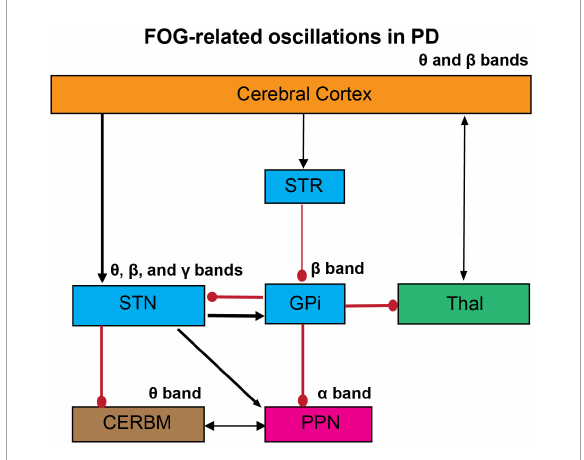
FIGURE1 The proposed oscillatory mechanism of FOG in PD. The abnormal gait in PD can be mediated by aberrant changes in the oscillatory activities across cortical and subcortical networks. FOG is associated with impaired cortico-striatal-thalamic circuits, which lead to an increase in glutamatergic input in the STN and pallidal inhibitory outflow. These abnormalities have been examined by the changes in neural and neuronal levels in humans and animal models. Here we propose the abnormalities in oscillatory activities in the whole networks, studied by EEG and LFP recordings. These studies suggest that the abnormal oscillations in these circuits can induce impaired co-ordination of flexor-extensor pairs in the lower limbs and ultimately the FOG. STR, striatum; GPi, globus pallidus internus; STN, subthalamic nucleus; Thal, thalamus; CERBM, cerebellum; PPN, pedunculopontine nucleus; Black arrows, excitatory; Red circles, inhibitory. The thickness of the arrows resembles to their presumed